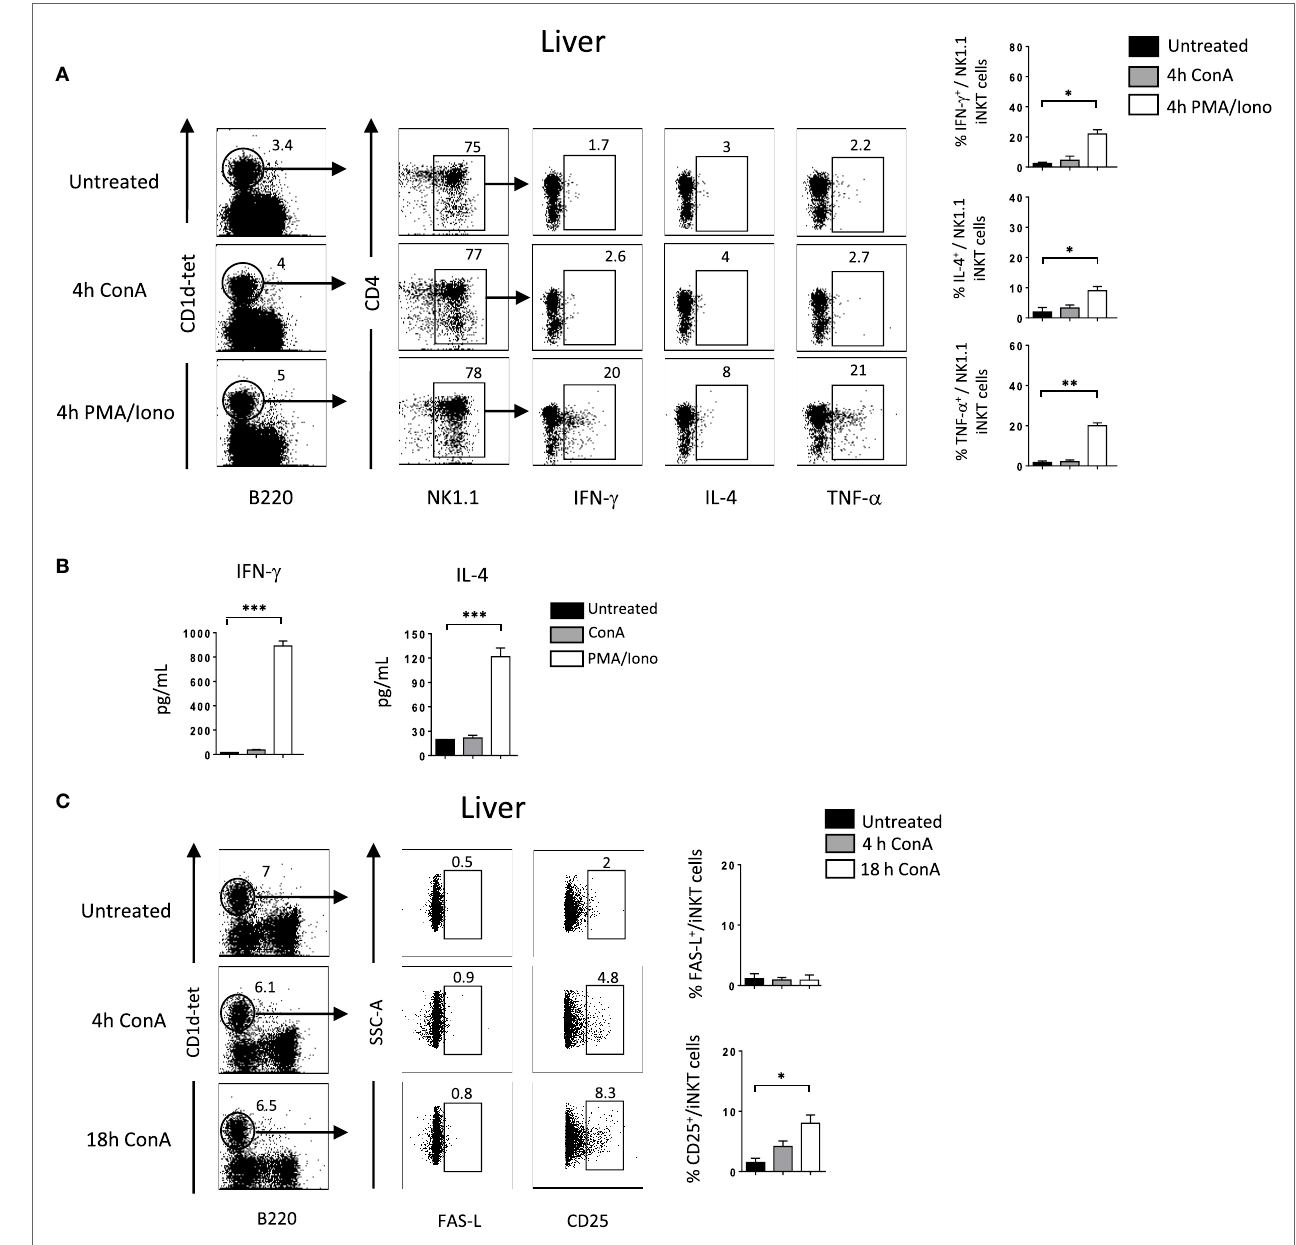
FigUre 6 | Cytokine production and FAS-L expression by liver invariant natural killer T cell (iNKT) cells is not induced directly in vitro by Concanavalin A (Con A) (a) . Representative intracellular staining of interferon (IFN)- γ , interleukin (IL)-4, and TNF- α production expression by liver NK1.1 + iNKT after 4 h incubation in the presence of Con A (10 µg/ml) or PMA/ionomycin. iNKT cells are defined as tet + B220 − . The frequencies of positive cells are shown in the histograms. (B) Cytokine level in the supernatant by liver mononuclear cells after O/N incubation with Con A or PMA/ionomycin at the previously indicated concentration. (c) Representative cell-surface staining of FAS-L expression by liver NK1.1 + iNKT after 4 or 18 h incubation in the presence of Con A (10 µg/ml). Results are from three to four experiments where three mice of each genotype were used per experiment and presented as mean ± SD. Significance is represented by an asterisk and was evaluated with non-parametric Mann–Whitney U